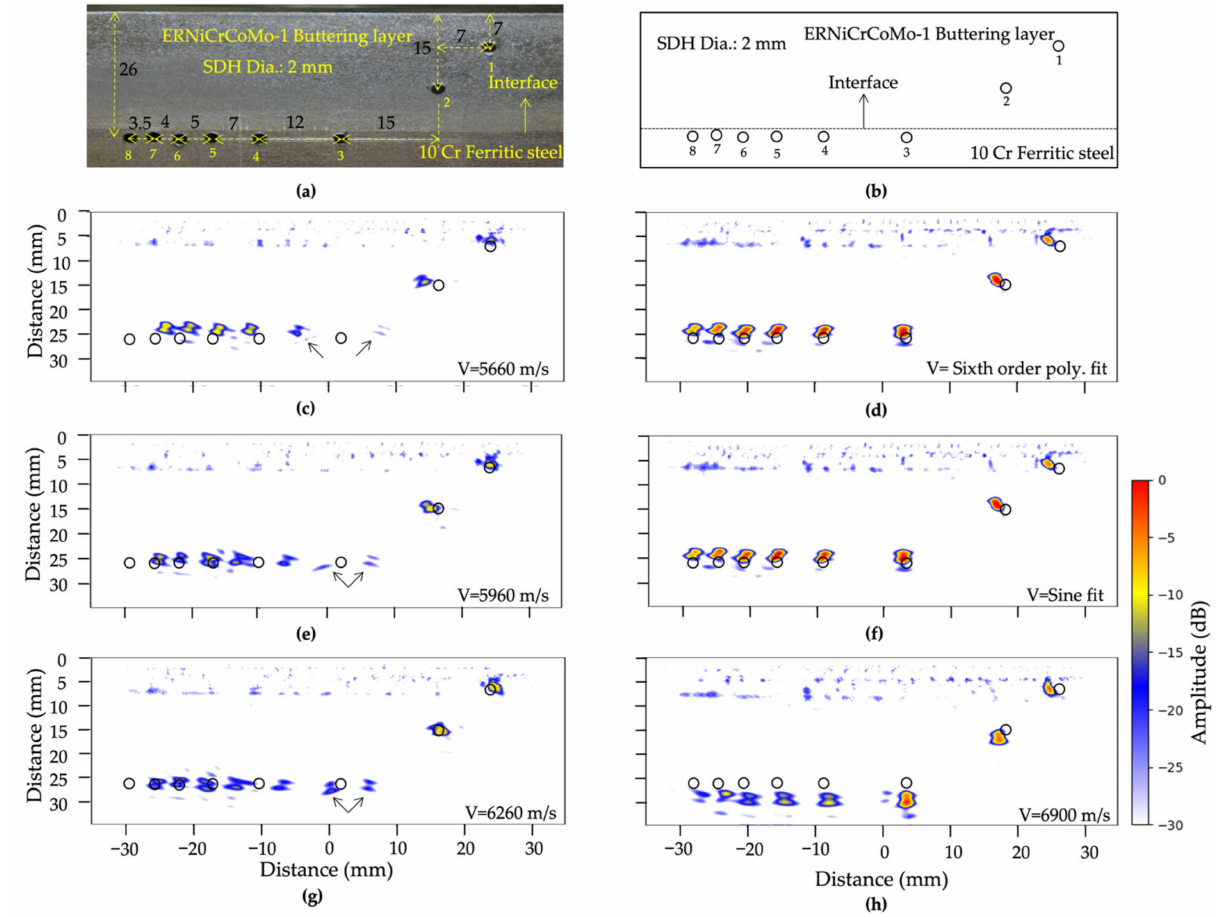
Figure 6. ( a ) Photograph and ( b ) schematic sketch of the reference block showing locations of side drill holes (SDHs). ( c , e , g ) are TFM images processed using isotropic ultrasonic longitudinal wave velocity values of 5660 m/s, 5960 m/s, and 6260 m/s, respectively. ( d , f ) provide TFM images generated using angle dependent ultrasonic velocities as per the sixth-order polynomial fit (Equation (3)) and the sine fit (Equation (4)), respectively. ( h ) TFM image generated using the alternate approach with an isotropic ultrasonic velocity of 6900 m/s. The amplitude values in dB scale for all the TFM images are calculated with respect to the maximum amplitude observed in ( d